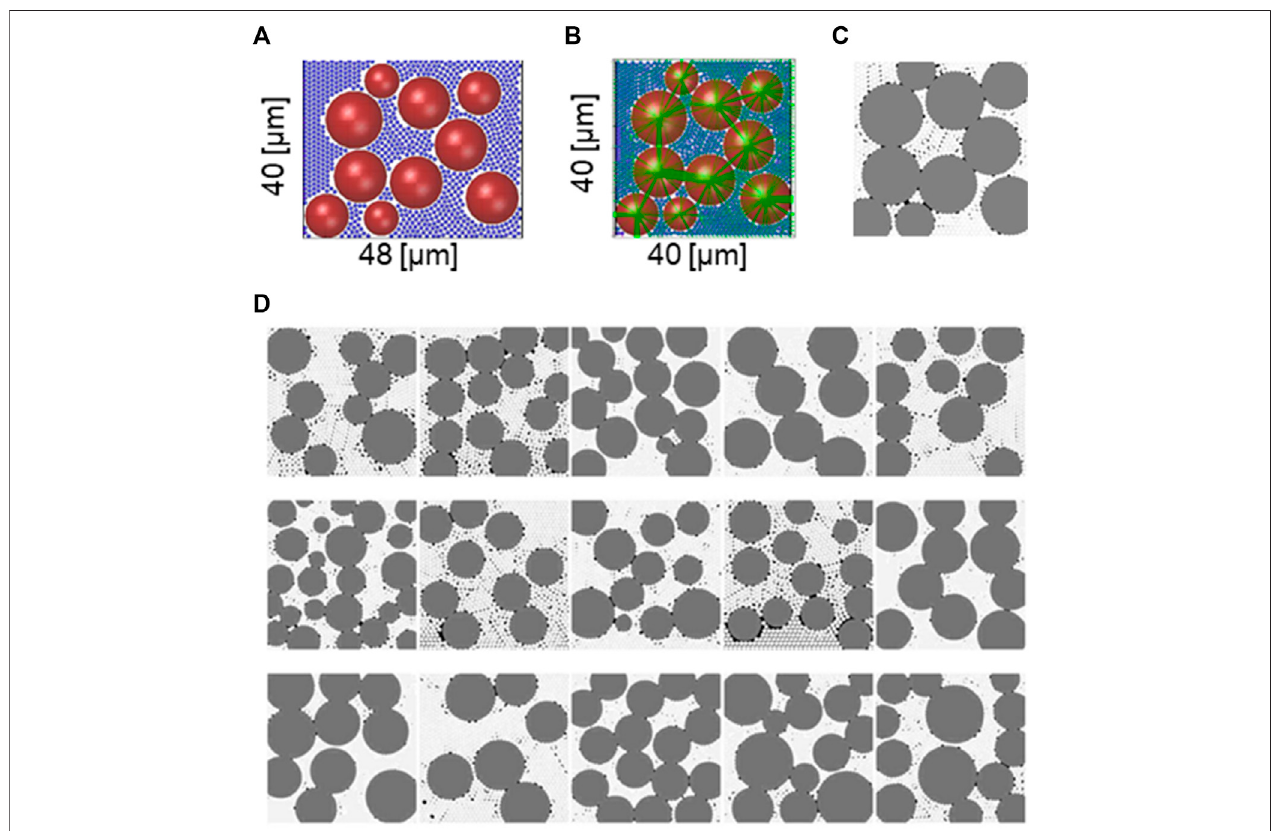
FIGURE3| Part ofthedataset created via DEM calculations. (A) Particle con fi guration beforeDEM calculation and (B) particle con fi guration after DEM calculation. Green lines indicate stress acting on the contact area, and the thickness of the line indicates the magnitude of the stress. (C) Triangulation of the structure in (B) . Five- hundred such images were created to form a data set, and a part is shown in (D)